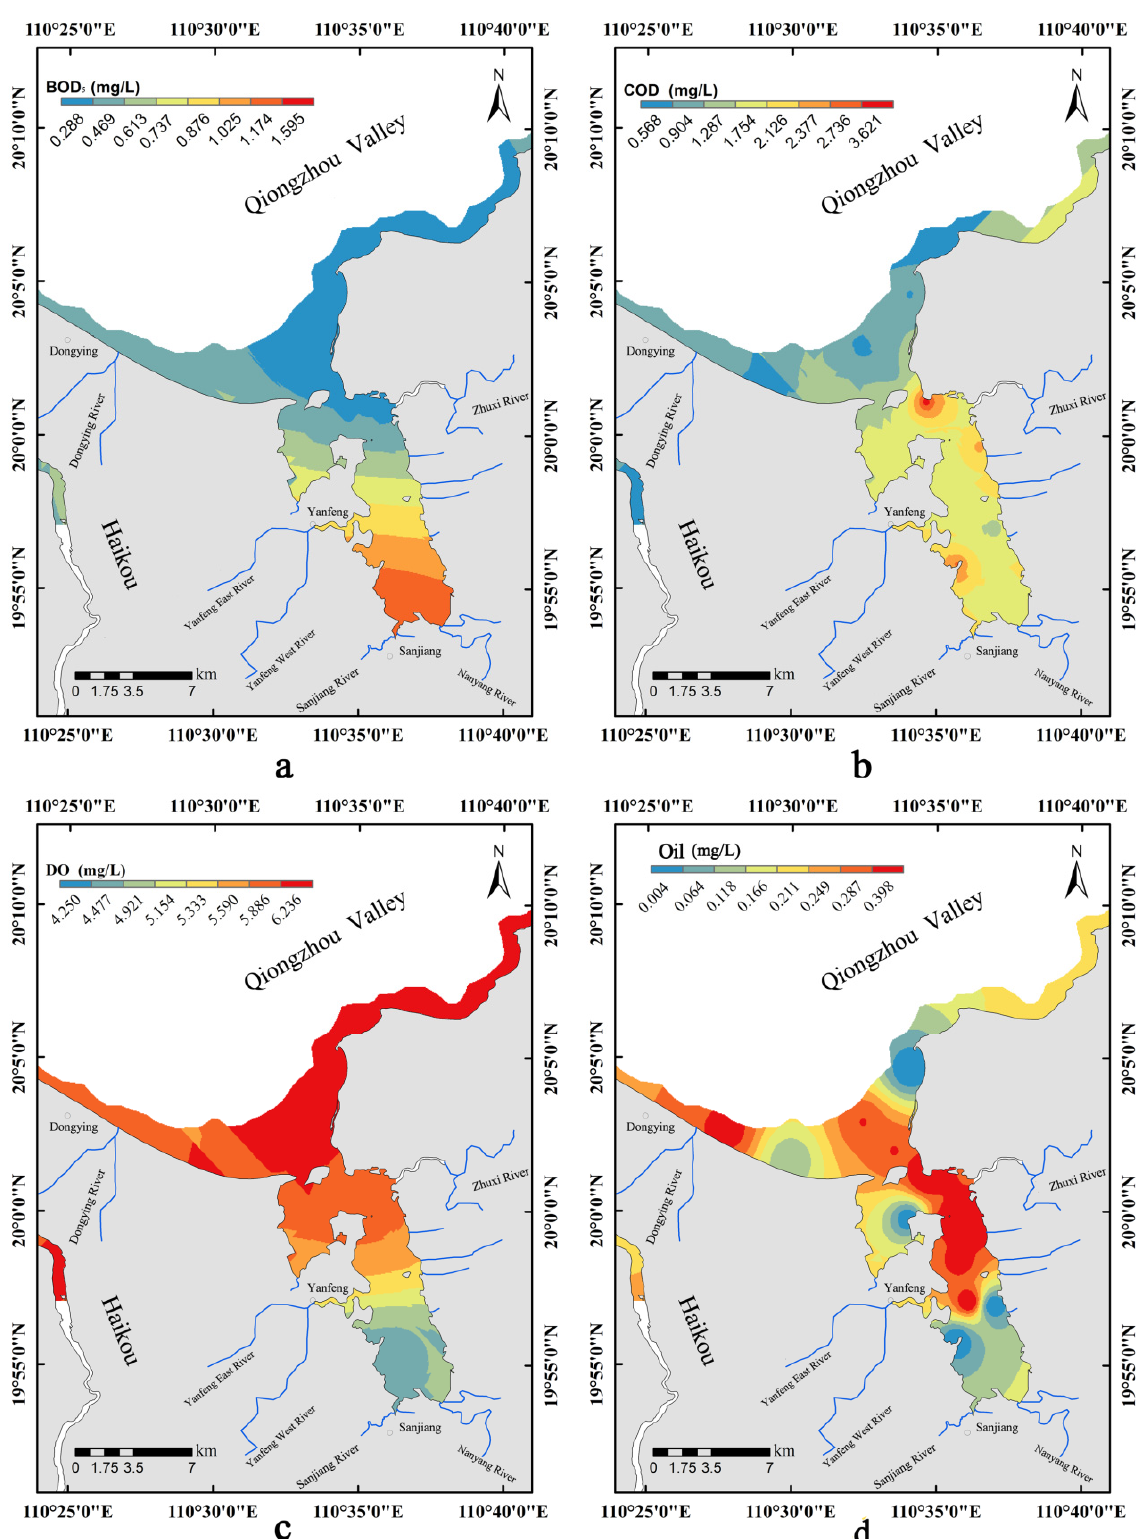
Figure 2. Spatial distribution of organic pollutants. ( a ) Spatial distributions of BOD 5 ; ( b ) spatial distributions of COD; ( c ) spatial distributions of DO; ( d ) spatial distributions of